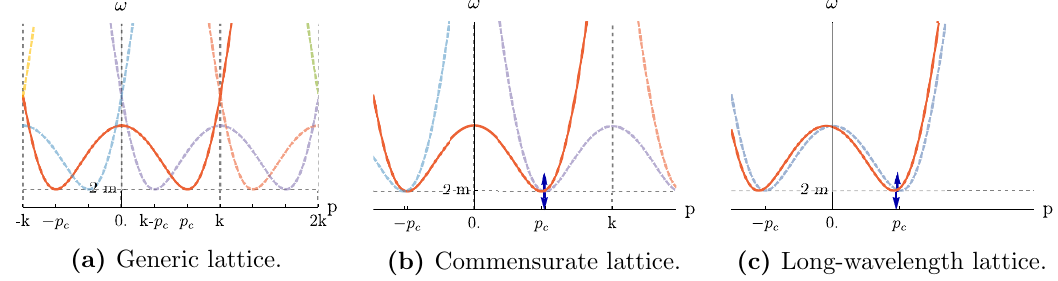
Figure 1 . Dispersion relation in the \double-well" toy model on top of a periodic background lattice with di(cid:11)erent wave-vectors. The dashed curves represent the \shifted" dispersions ! n (~ p ) = p D ~ p + nk . The blue arrows show the eigenmode repulsion leading to decrease of the ground state energy in the commensurate and long-wavelength